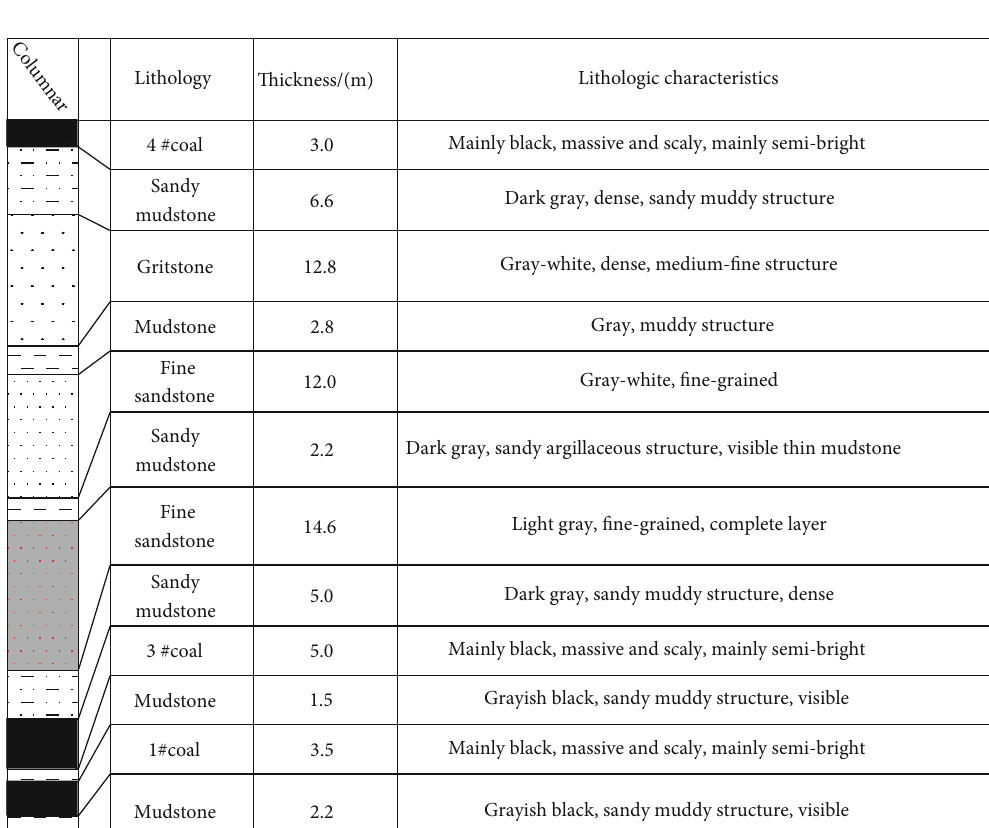
Figure 1: The layout of the working face.